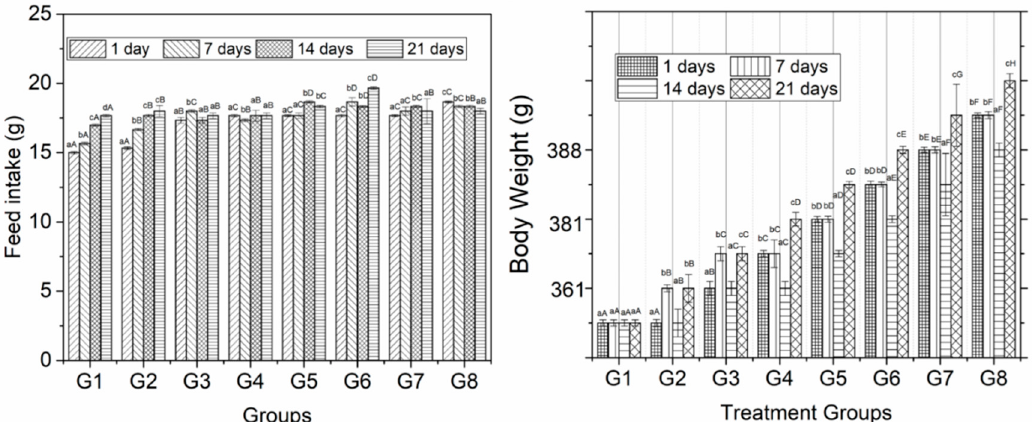
Figure 1. Feed intake and body weight of mice supplemented with different concentrations of guava leaves, seeds and pulp extract. Feed intake was calculated by subtracting leftovers from total food fed on each day. Error bars show the standard deviation (SD) of three replicate measurements. Uppercase letters (A–C) on error bars show significant differences ( p < 0.05) in treatment times within the same treatments. Lowercase letters (a–c) show the significant difference ( p < 0.05) among treatments within the same time. Table 2. Biochemical and blood serum characteristics of mice fed with and without the supplementation of guava extracts during 3 weeks of administration. Groups